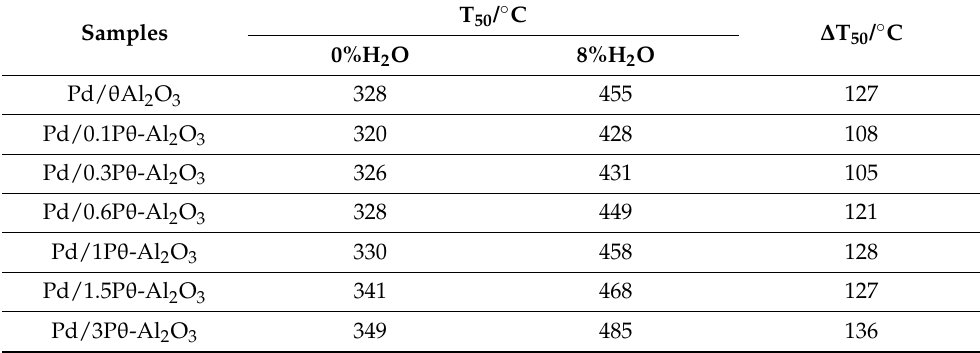
Figure 7. Light off test curves of Pd/xP θ -Al 2 O 3 catalysts for methane catalytic combustion in the absence ( a ) and presence of 8% water. ( b ) Condition: 2000 ppmCH4 + 5%O 2 + 0%H 2 O (or 8%H 2 O) + N 2 balance, GHSV = 36,000 h − 1 . Table 1. The T 50 of light-off